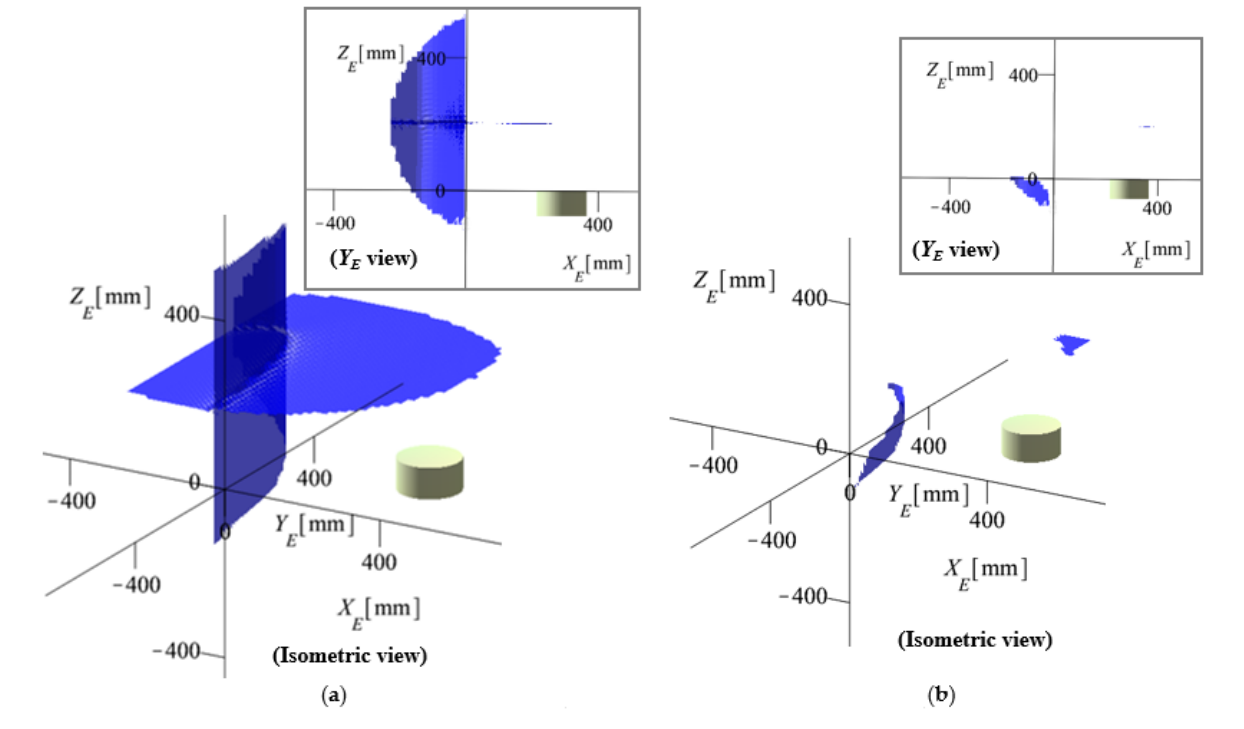
Figure 20. Output singularity configuration for the angle values { ψ = 0, θ = 0, φ = 0}.